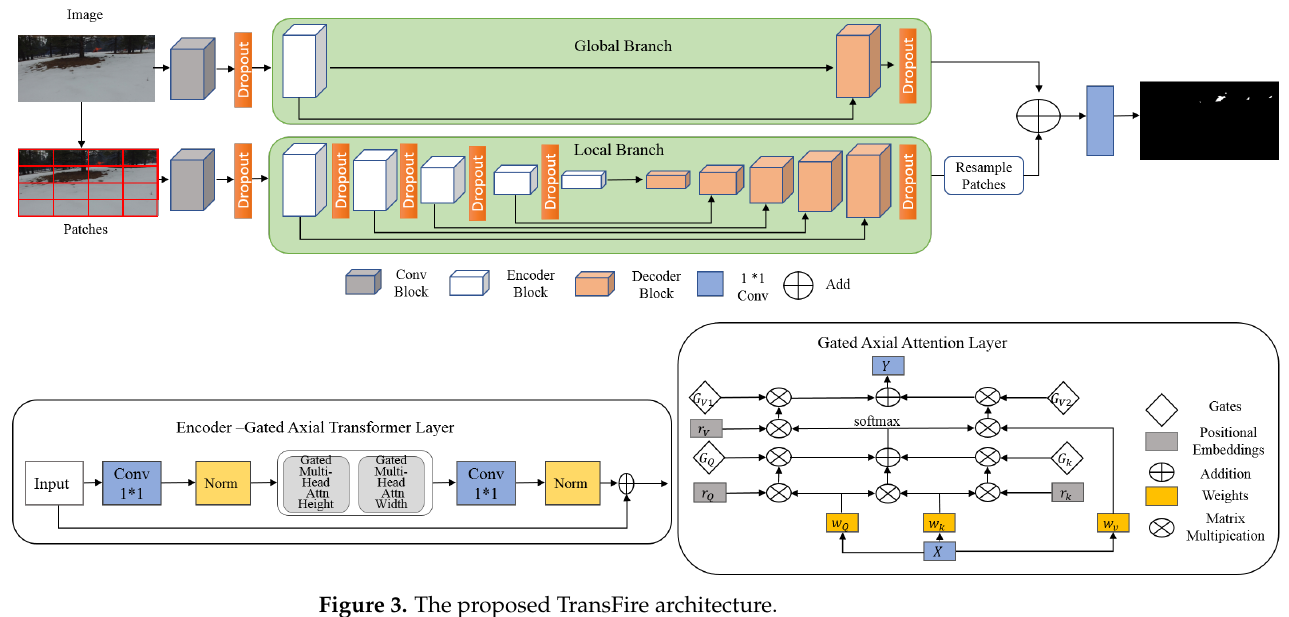
Figure 3. The proposed TransFire architecture.